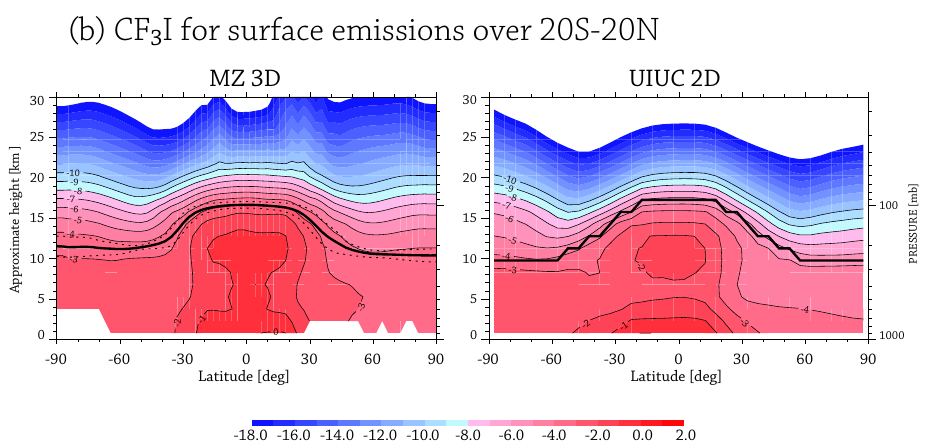
Fig. 5. Annually averaged CF 3 I mixing ratios introduced into the atmosphere by one teragram of total CF 3 I surface emissions in ranges of (a) mid-latitudes and (b) tropics. The base 10 logarithm was taken of the CF 3 I mixing ratios determined by the two scenarios using two different models after being scaled as per teragram CF 3 I loading. The MOZART-3 3-D (UIUC 2-D) model results are on the left-hand- side (right-hand-side). The tropopause levels are denoted by thick line and the 3-D model results only includes detailed topography and tropopause